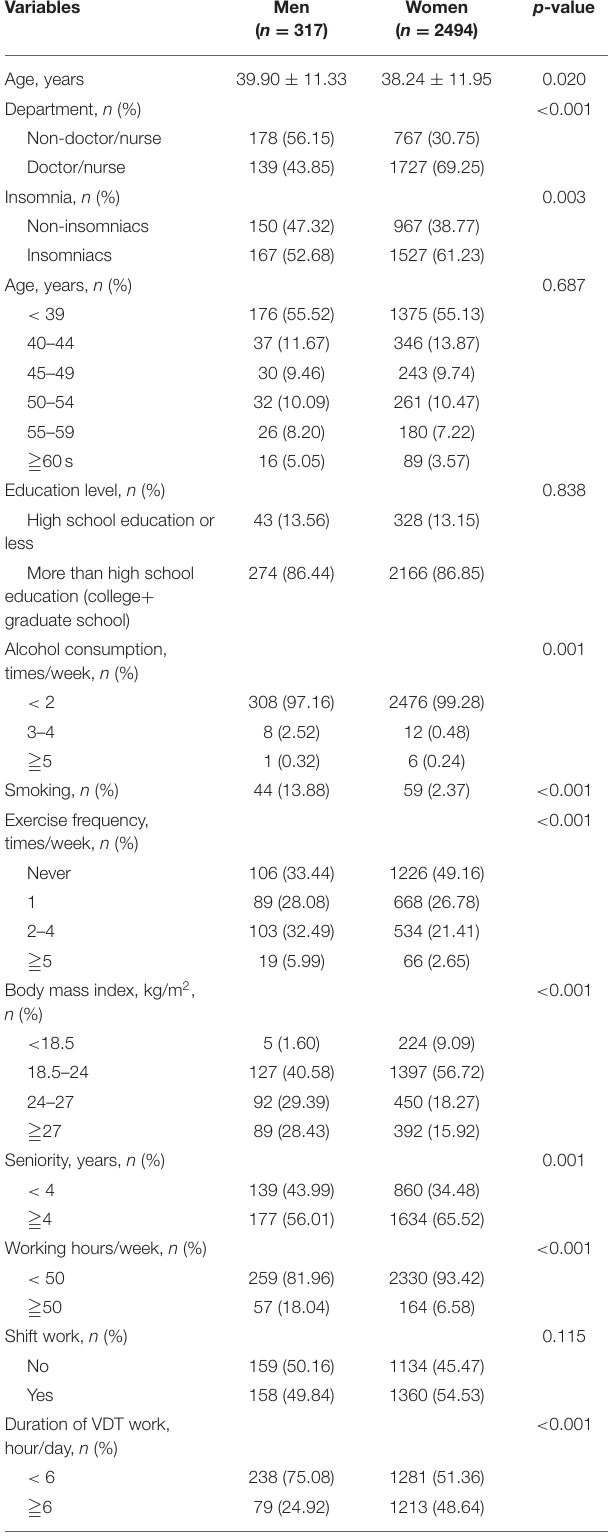
TABLE 1 | Characteristics of men and women